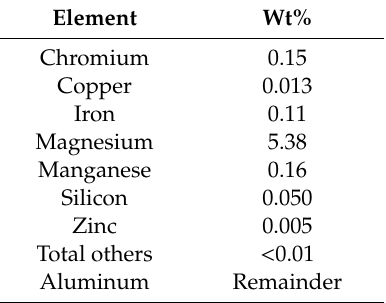
Table 1. Composition of Al 5056 powder as determined via direct current plasma emission spectroscopy